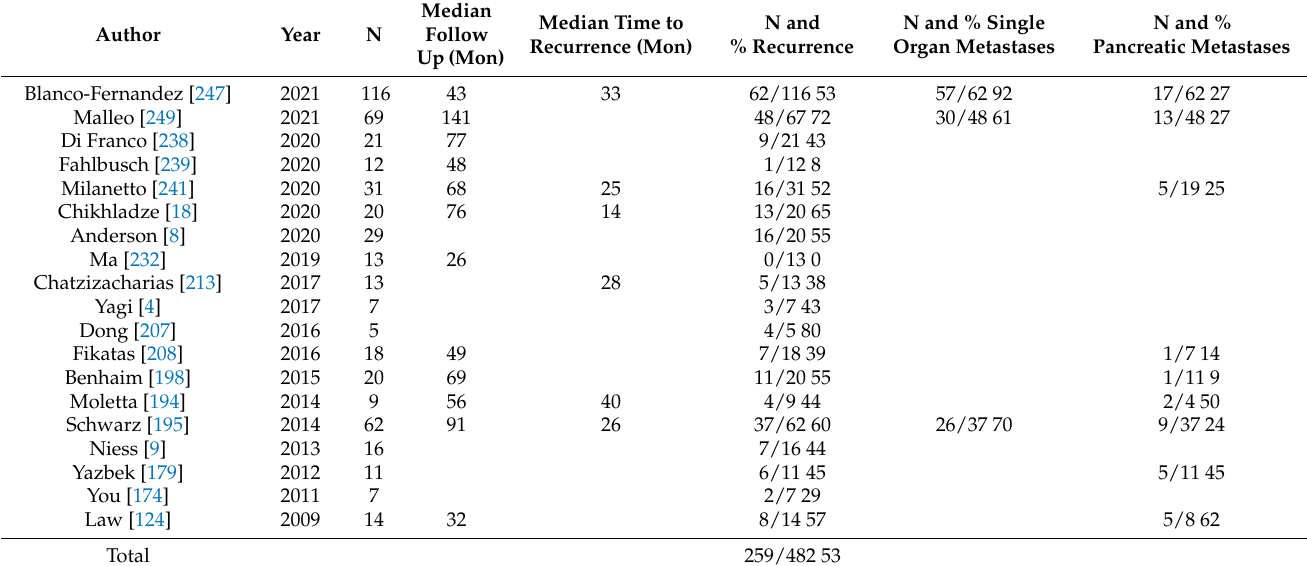
Table 4. Recurrent disease following treatment of